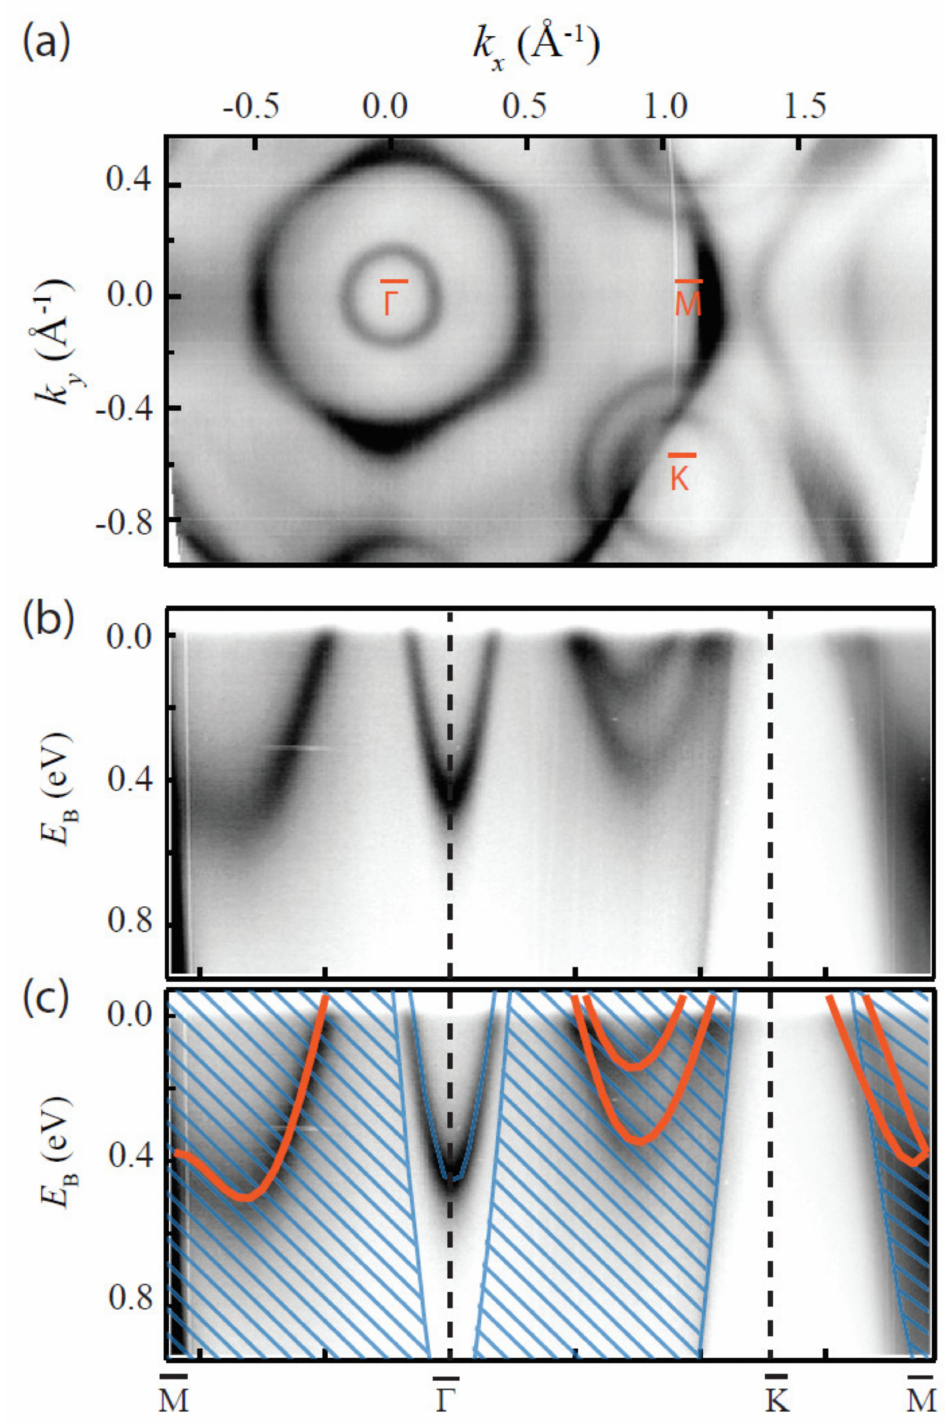
Figure 7. Electronic structure of monolayer TaS 2 measured with ARPES. ( a ) Photoemission intensity at the Fermi energy. ( b ) Photoemission intensity along high-symmetry directions of the 2D Brillouin zone. ( c ) Data in ( b ) with the calculated 1 H -TaS 2 band structure superimposed in orange. The calculated bands were shifted by 0.12 eV to higher binding energy. The Au surface state and projected bulk bands of Au(111) are indicated with blue, as guides to the eye. Reprinted figure with permission from Reference [118]. Copyright 2016 by the American Physical